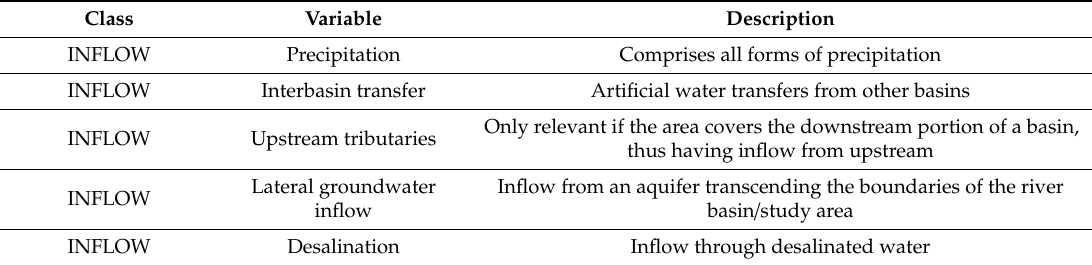
Table A1. Resource base sheet components and